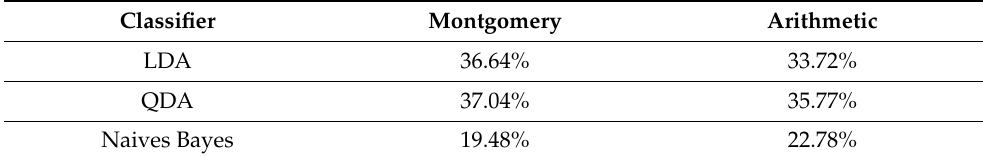
Table 7. Classifier output for modular